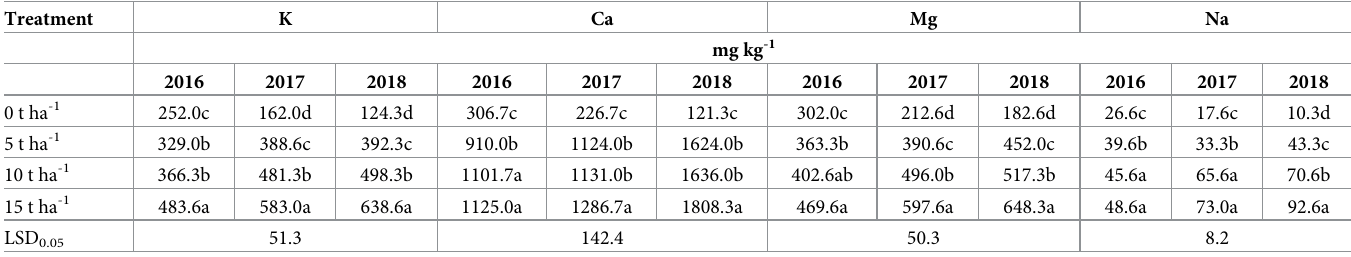
Table 7. Soil exchangeable cations (K, Ca, Mg and Na) as influenced by compost application rates over a three year study (2016 to 2018) at the Mooketsi orchard. Treatment